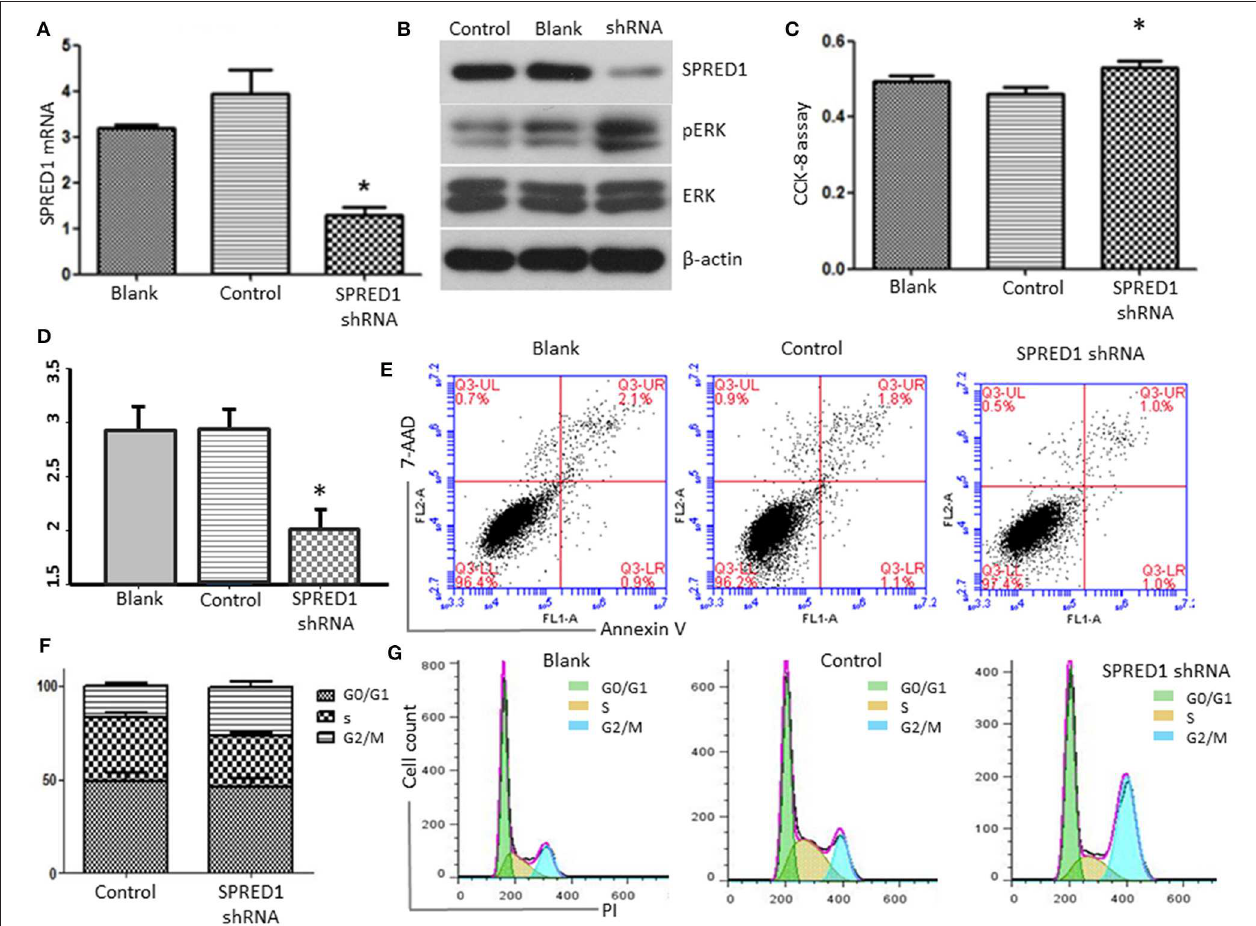
FIGURE 8 | OCI-AML3 cells were transfected with SPRED1 shRNA for 48h. (A) SPRED1 mRNA was determined by RT-PCR; (B) SPRED1, pERK, ERK, and β -actin were assessed by immunoblotting; (C) cell proliferation was determined by CCK-8 assay; (D,E) cell apoptosis and (F,G) cell cycle distribution was assessed by flow cytometry. * p < 0.05 vs. control (Student’s t